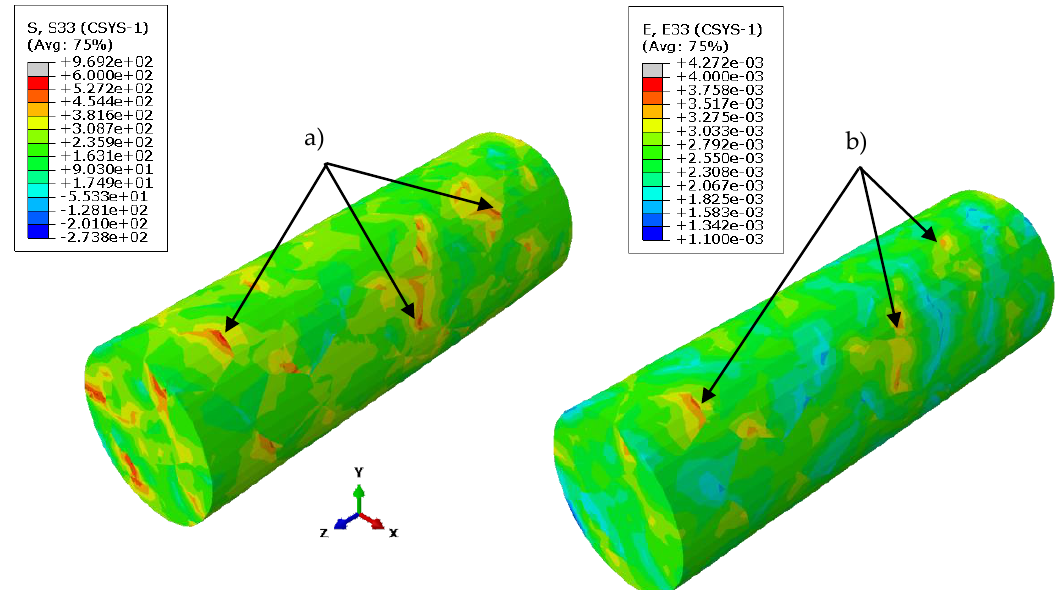
Figure 10. Stress and strain distribution in loading direction for the specimen model with 500 grains and directed orientation distribution at 0.25% total strain. An anisotropic elasticity model of IN 738 LC at 850 °C was applied.